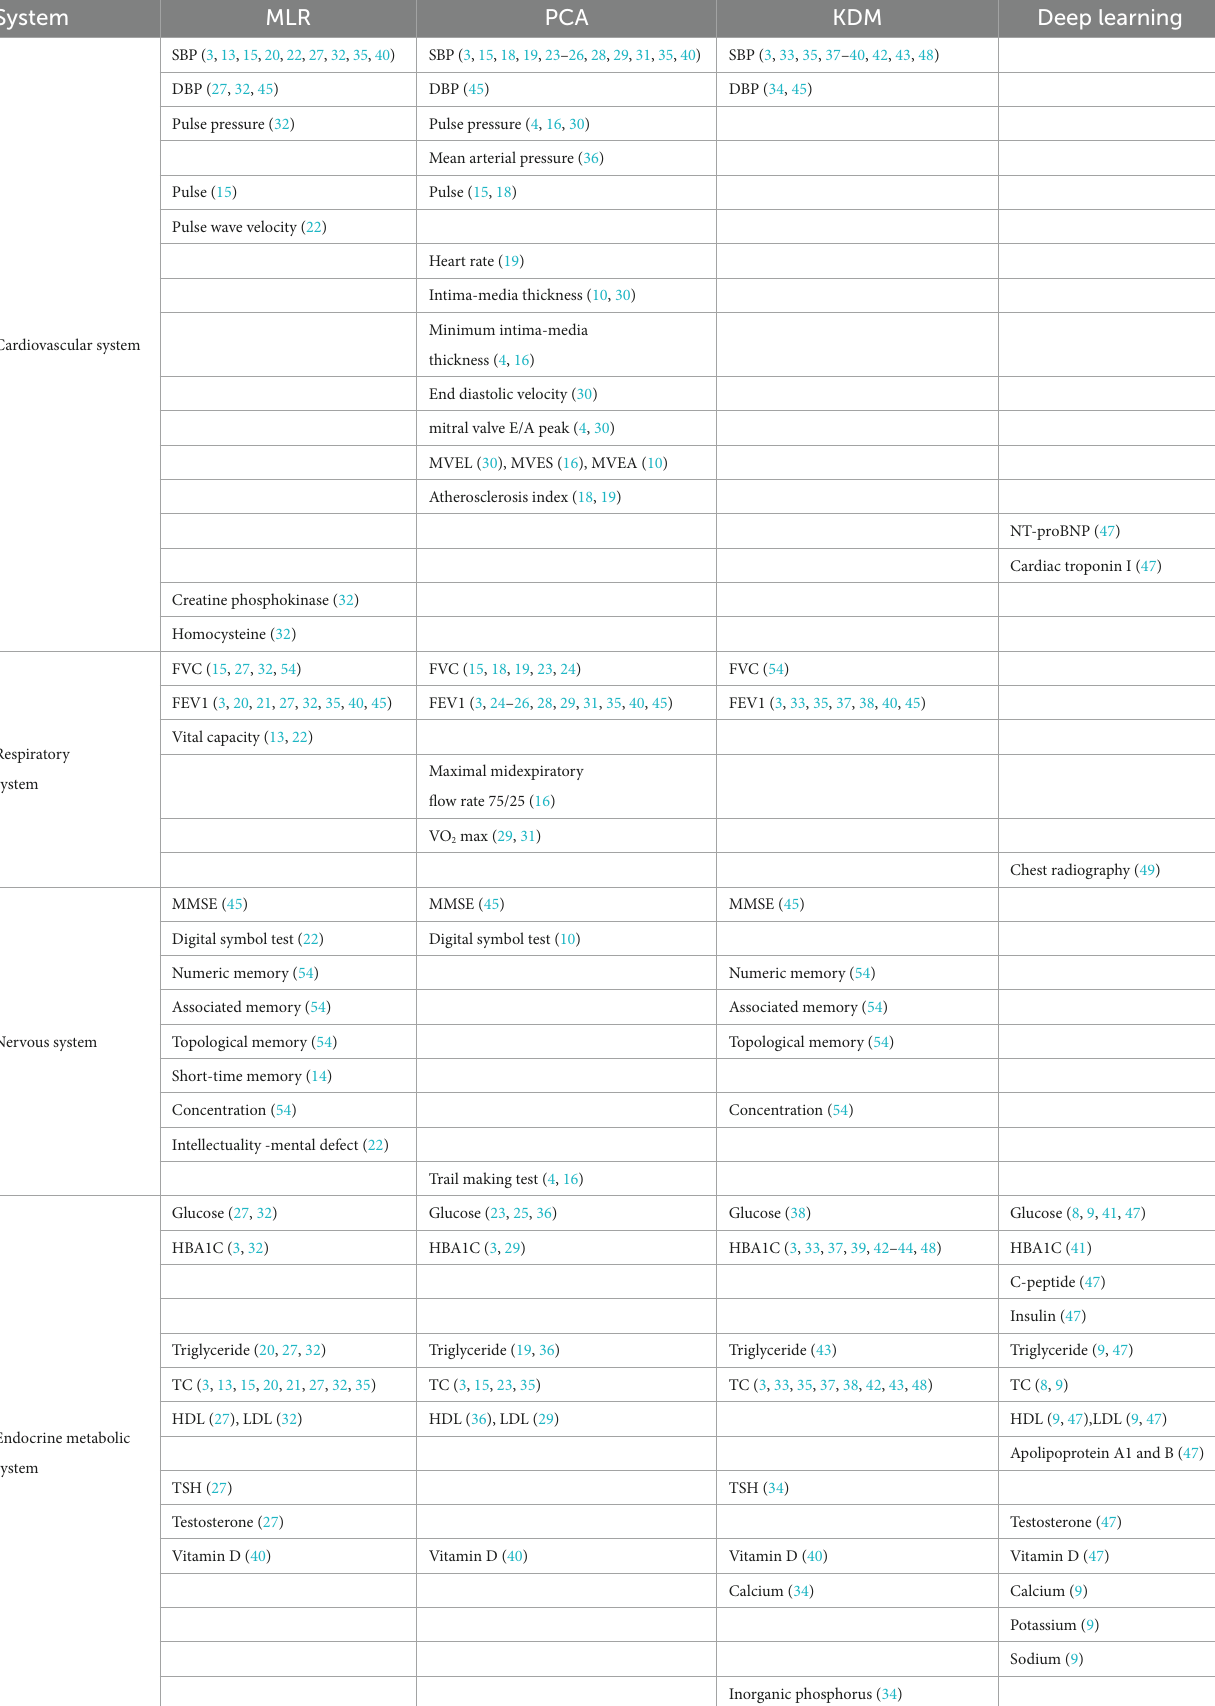
TABLE 3 The common aging biomarkers of four methods in different systems.